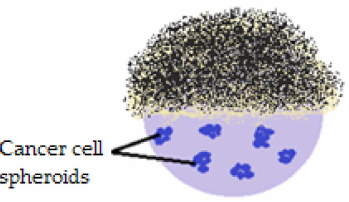
Figure 18. PTFE covered liquid marbles (section) used to observe cancer cell interactions in